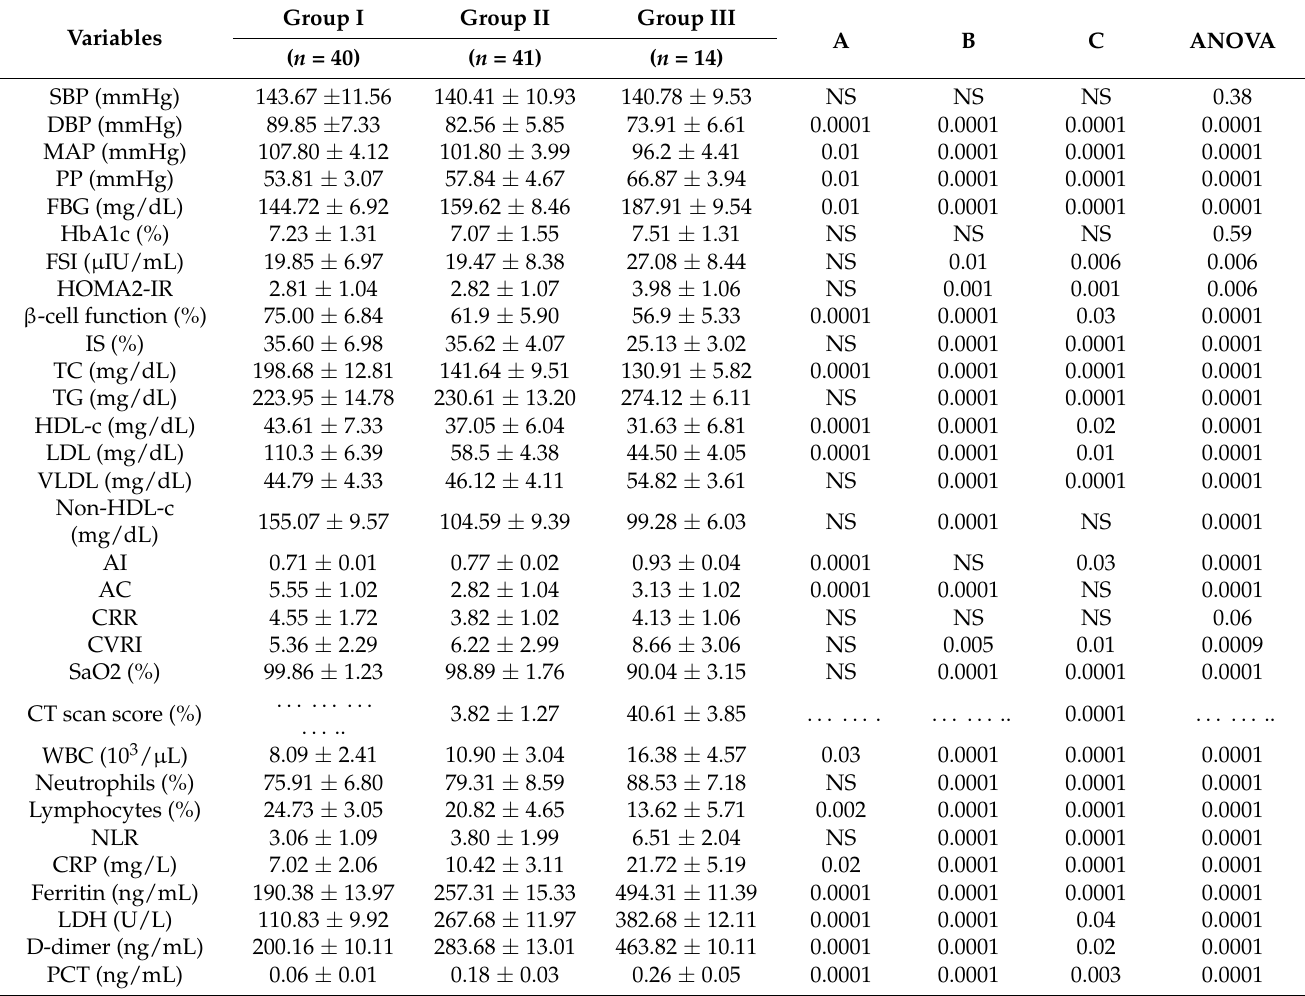
Table 1. Metformin effects on the anthropometric and biochemical variables in T2DM with COVID-19 relative to T2DM